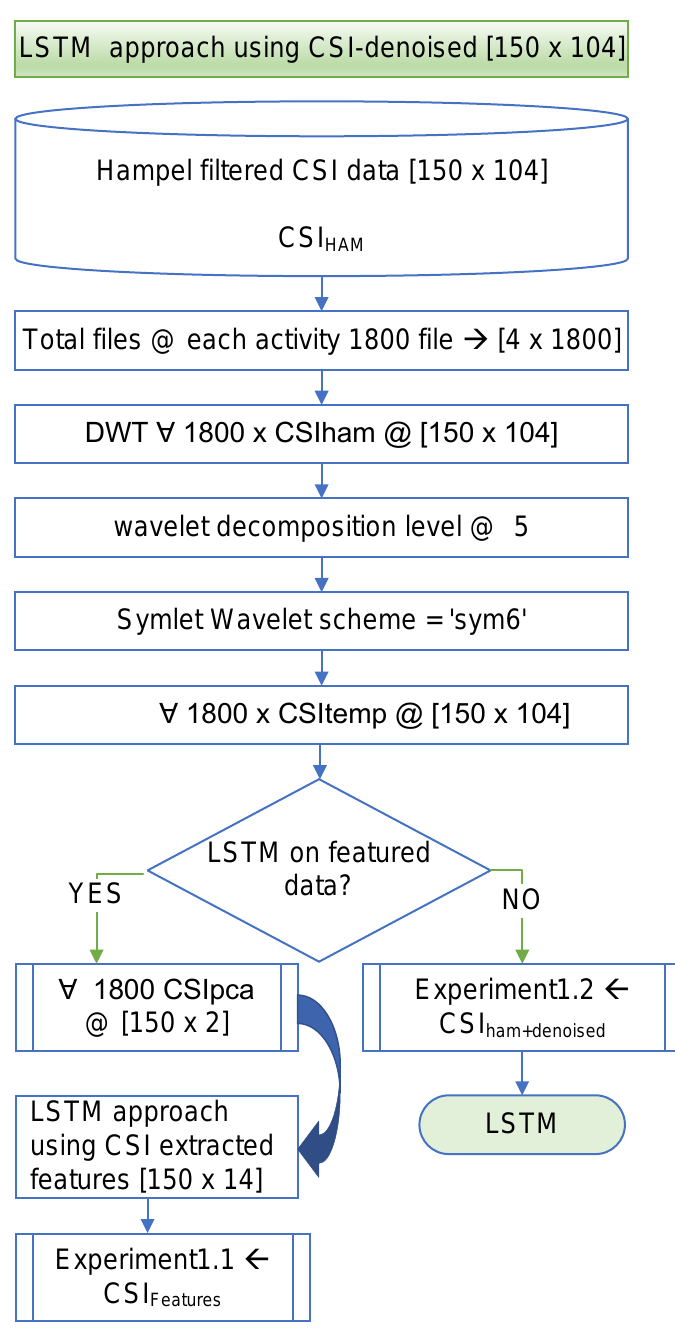
Figure 10. LSTM data matrix selection for Experiment 1.1 and Experiment 1.2. In the second approach, the activity file is denoised without PCA, without selectively extracted features, as shown in Figure 10. Preferably the whole data matrix [150 × 104] which is Experiment 1.2 is used as an input for the training/testing of LSTM. The second approach is used to avoid losing vital features from the data while selecting the 14 features based on PCA reduced